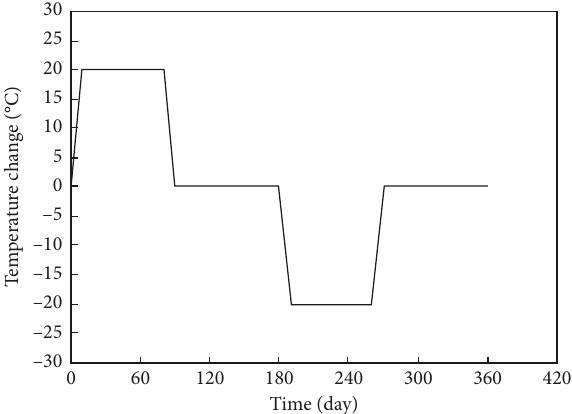
Figure 10: Temperature variation of the pile in one